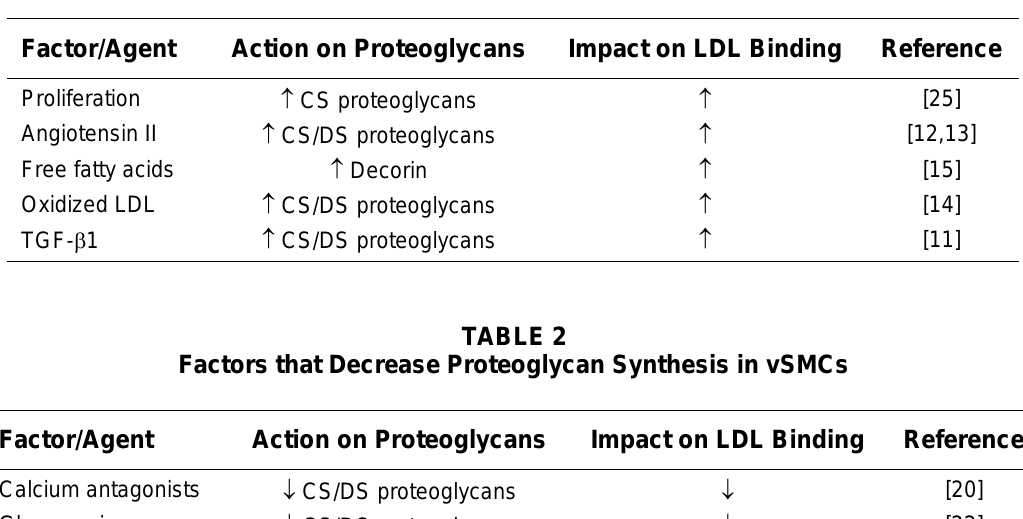
Factors that Increase Proteoglycan Synthesis in vSMCs